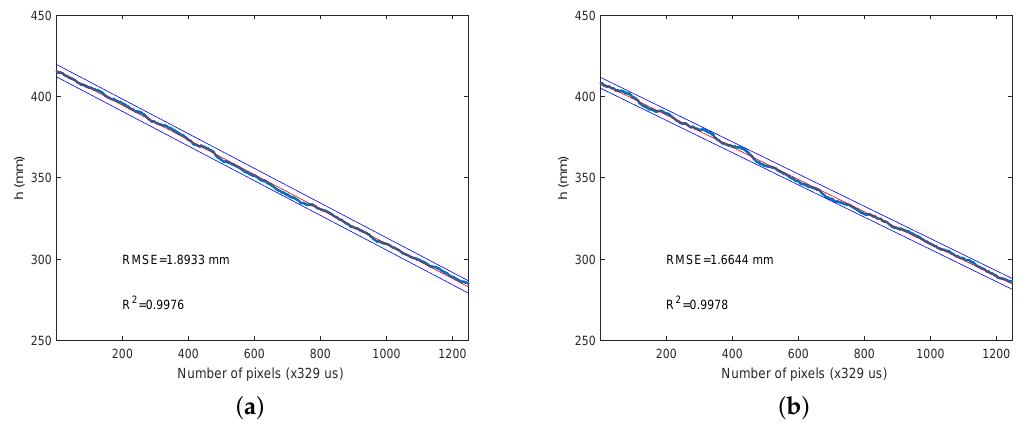
Figure 10. ( a ) Approaching a white plaster wall experiment; ( b ) approaching a blue painted wooden door